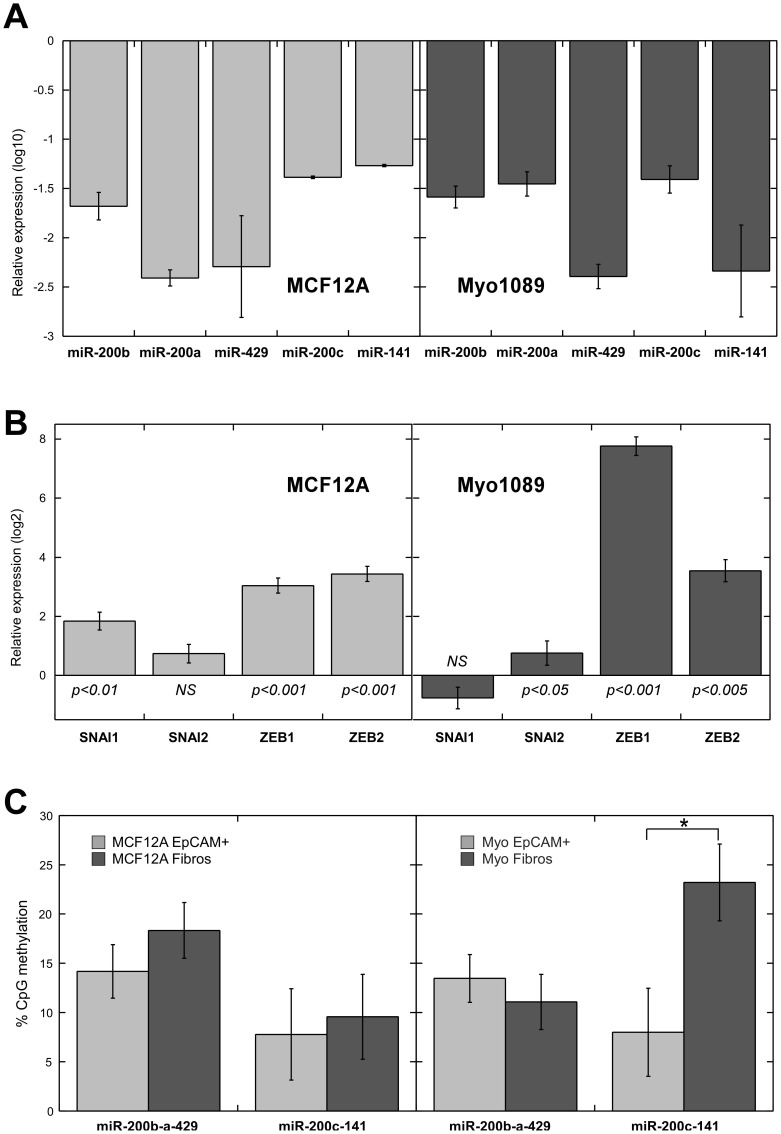
miR-200f and EMT-transcriptional inducers are modulated during in vitro EMT in breast basal cell lines.Expression of (A) miR-200f and (B) EMT-transcriptional inducers was evaluated by qRT-PCR in the sorted epithelial (EpCAM+) and mesenchymal (Fibros) subpopulations within MCF12A and Myo1089 cell lines. Data are normalized to the expression of RNU48 and 18S respectively. Bars represent mean expression changes ±SE in Fibros subpopulation relative to EpCAM+ cells (baseline). Three biological replicates were measured. Moderated t-test was performed to evaluate statistical significance (p<0.001 for all miRNAs analyzed in panel A. NS, non significant). (C) Methylation status of miR-200f promoter sequences in EpCAM+ and Fibros subpopulations within MCF12A and Myo1089 cell lines. Histogram bars represent averaged methylation levels (±SE) for the promoter sequences of miR-200f loci. Statistically significant differences are indicated (*p<0.001, Student’s t-test).